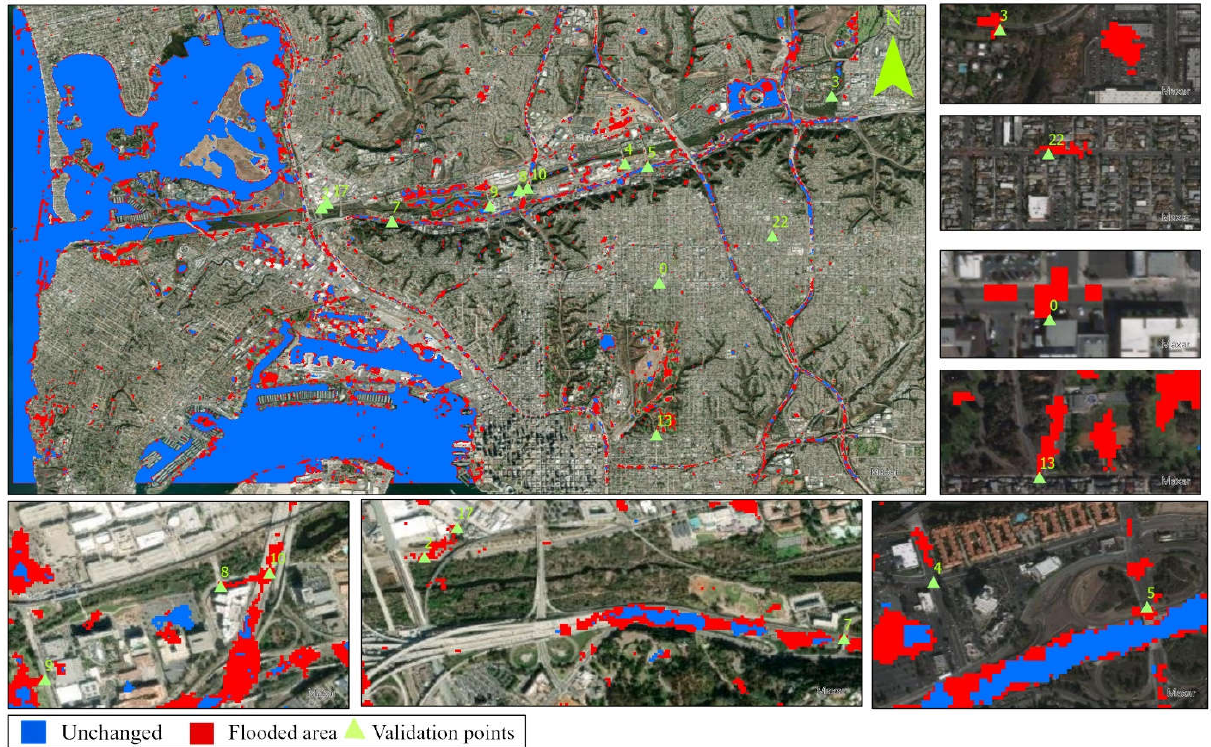
Figure 7. 2017 flood scenario obtained using the change detection method.